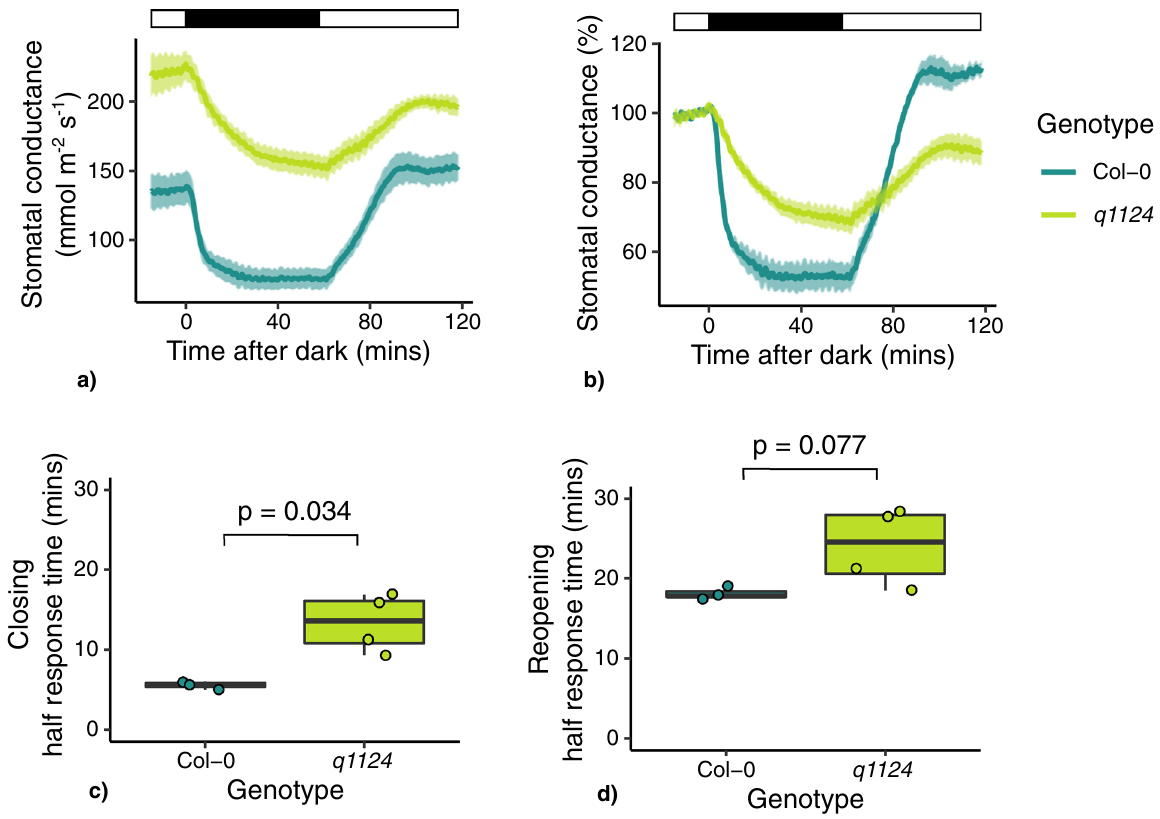
Figure 4. q1124 stomatal conductance responses to darkness at midday. Stomatal conductance of q1124 ABA quadruple receptor mutant was measured in response to darkness applied 4–5 h post dawn. ( a ) Absolute and ( b ) relative stomatal conductane values are presented as the mean ± s.e.m. The time taken to reach half of the maximum stomatal conductance change (half response times) in response to ( c ) darkness and ( d ) light are presented in boxplots showing the median and interquartile ranges. 3–4 plants measured per genotype. Light treatment is represented above each stomatal conductance plot, with black boxes representing darkness and white boxes representing